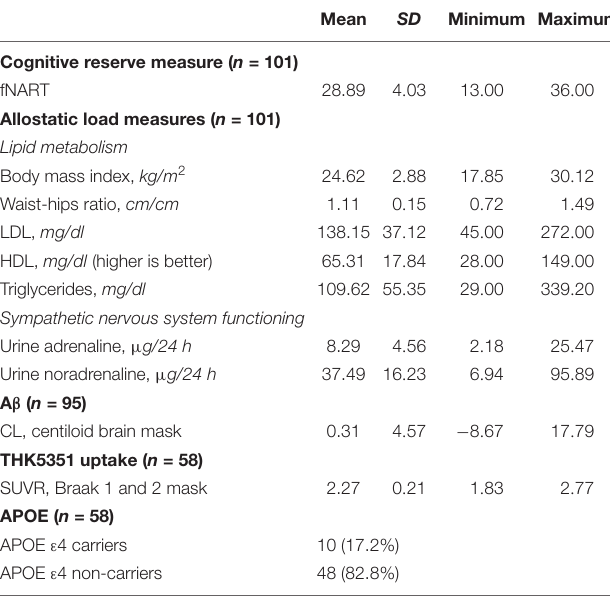
TABLE 2 | Descriptive statistics of raw values of cognitive reserve, allostatic load, A β , tau, and